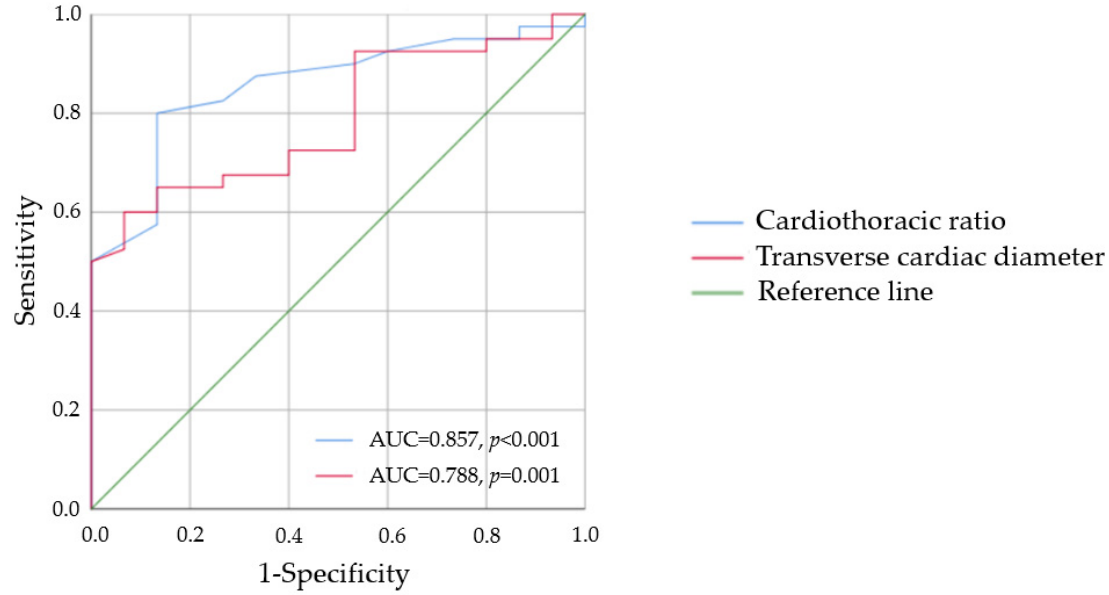
Figure 1. Area under the curve of chest radiograph criteria representing the predictive performance of left ventricular hypertrophy based on left ventricular mass indexed by body surface area. AUC—area under the curve.